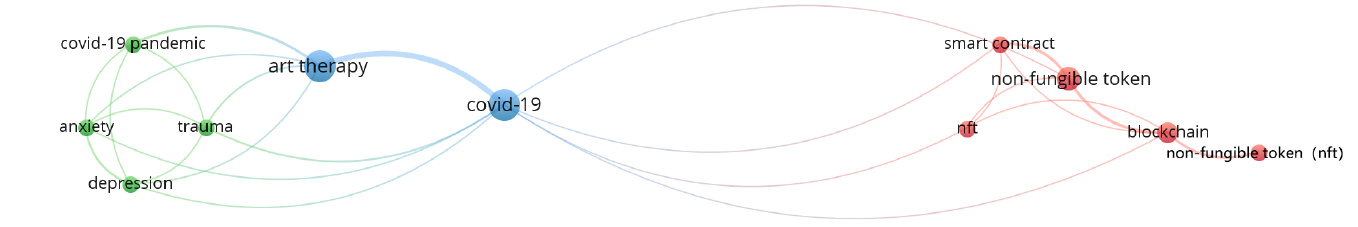
Figure 13. The relationship between art therapy and non-fungible tokens in the context of COVID-19 (generated by authors).